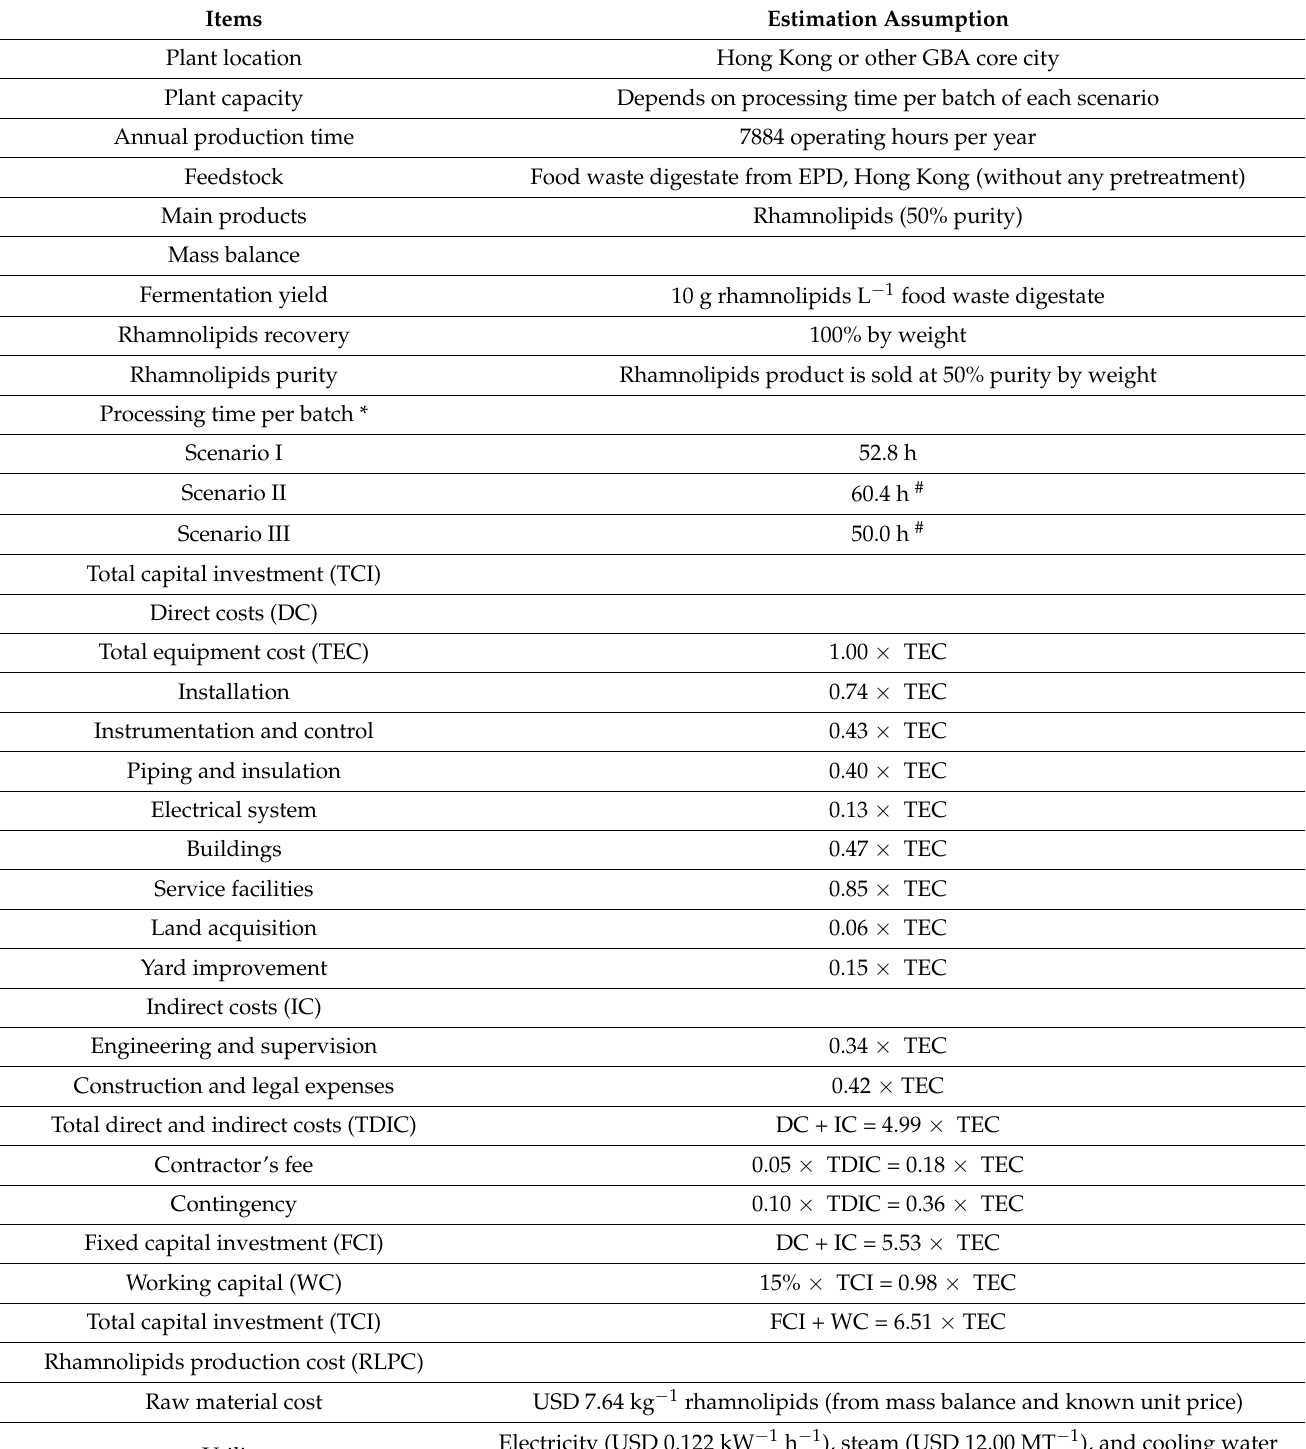
Table 1. General parameters for techno-economic